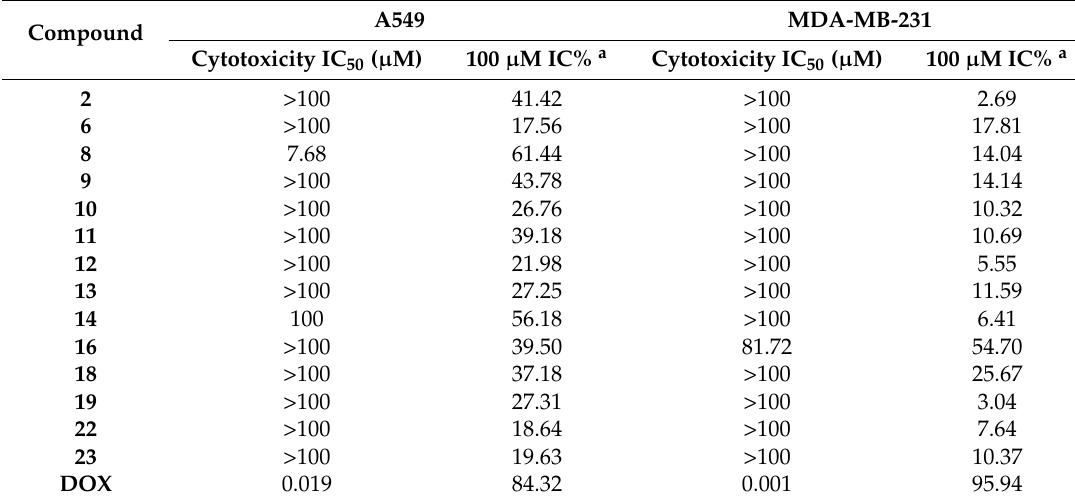
Table 2. Antitumor activity of newly synthesized